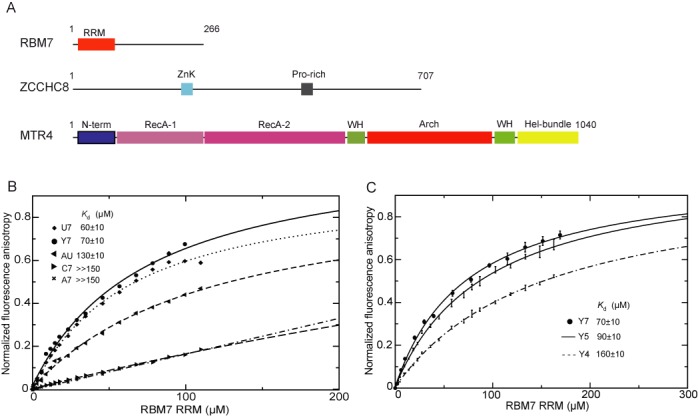
The RBM7 RRM domain exhibits specificity for U-containing oligopyrimidin sequences. (A) Schematic representation of the domain organization of NEXT complex subunits. Length of each protein in amino acids is indicated on the right. The boxes mark individual domains or protein regions; RRM, RNA recognition motif, ZnK, zinck knuckle, Pro-rich, proline-rich, N-term, N-terminal, RecA, helicase domain, WH, winged-helix domain, Hel-bundle, helical bundle. (B) Equilibrium binding of the RBM7 RRM with different fluorescently labeled RNA substrates monitored by fluorescence anisotropy. Binding isotherms and dissociation constants (Kd) are shown for each substrate. (C) RBM7 RRM requires minimum 4 nt RNA for binding. Equilibrium binding of the RBM7 RRM with fluorescently labeled polypyrimidin RNA substrates of varying lengths monitored by fluorescence anisotropy. Binding isotherms and dissociation constants (Kd) are shown for each substrate.